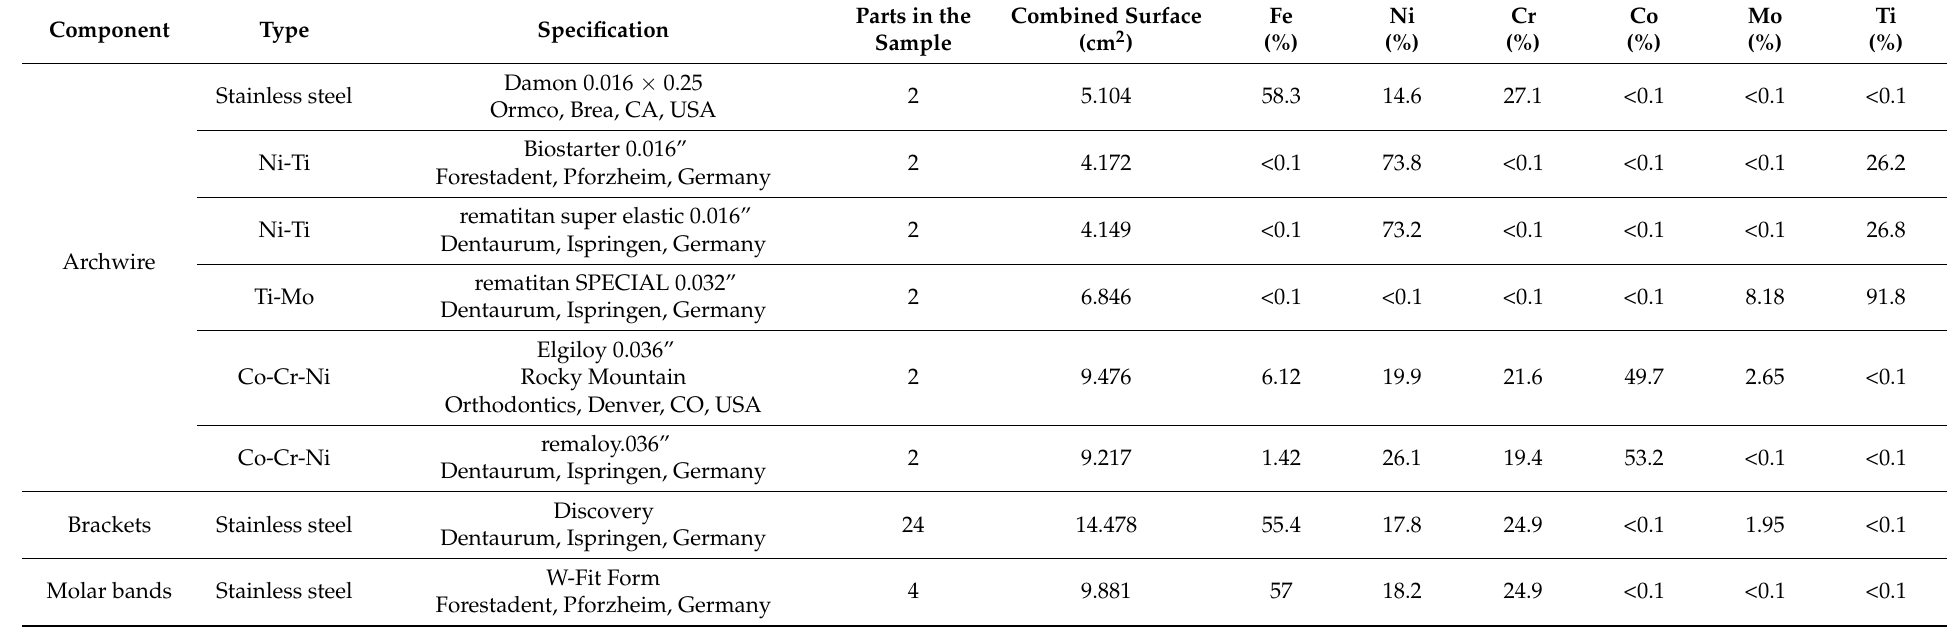
Table 1. Orthodontic materials used in the study with their corresponding metal composition in weight percentages (%).